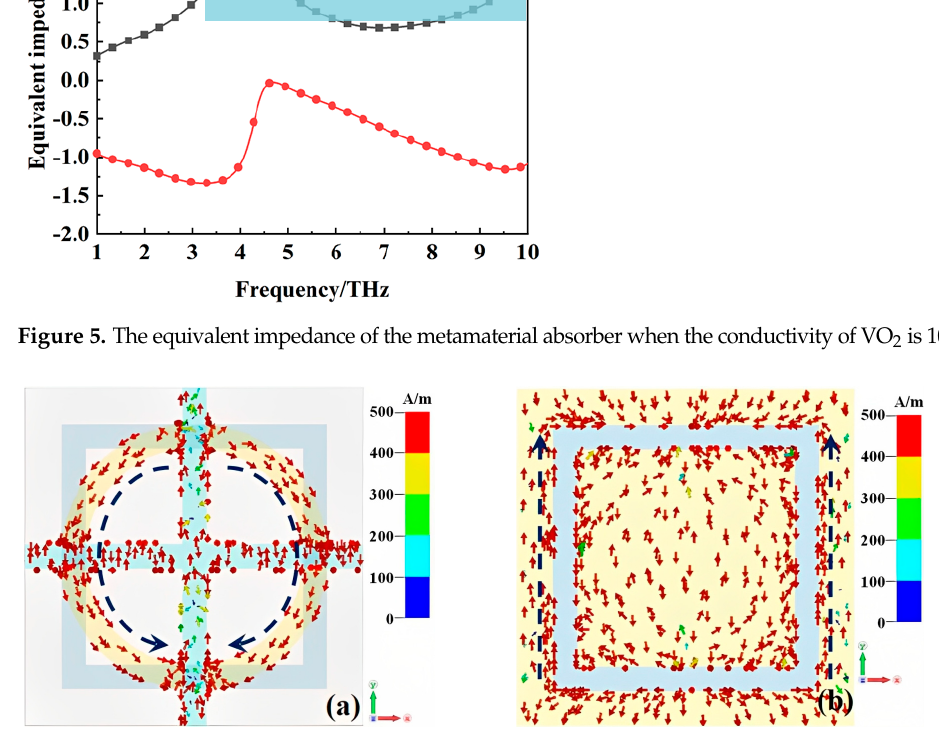
Figure 6. The surface current distribution of the metamaterial absorber at 8 THz when the conductivity of VO 2 is 2 × 10 5 S/m, ( a ) front layer; ( b ) bottom layer.